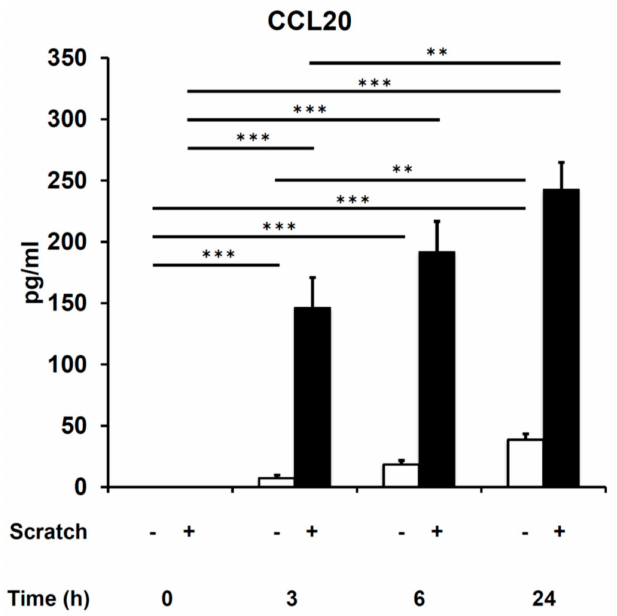
Figure 1. Scratch injury–induced CCL20 production. The production of CCL20 was measured at 3, 6, and 24 h after the initiation of culture in non-scratched control and scratched keratinocyte cultures. Representative data of three independent experiments are shown. ** p < 0.01. *** p < 0.001.